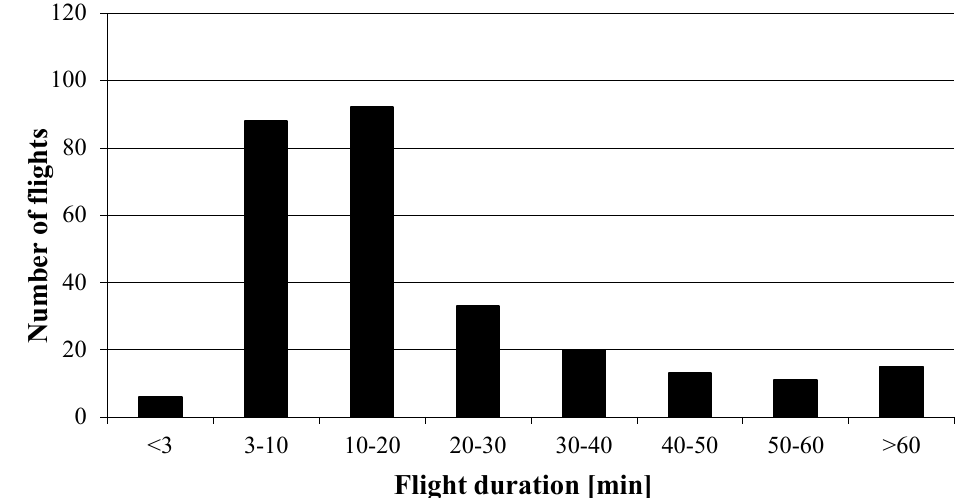
Figure 3. Number of flights with a specific